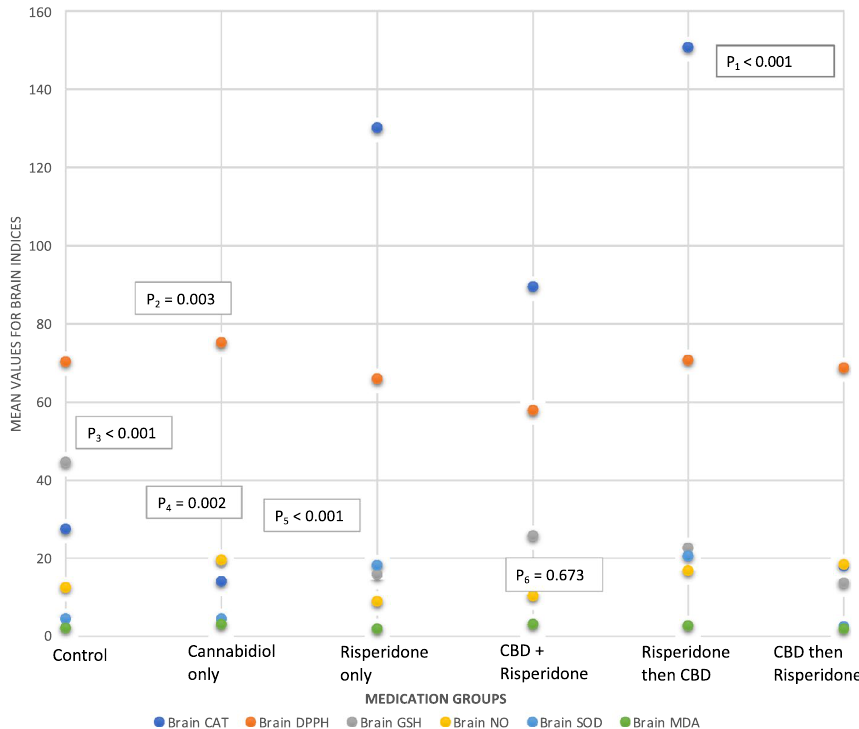
Figure 4. Inter-group comparison of assay of antioxidant indices assay after the last dose of medications. There were intergroup differences in the Brain’s GSH, SOD, CAT, SOD and DPPH results, but there were no intergroup differences in the brain’s MDA. Group 1: Control Group; Group 2: Cannabidiol only; Group 3: Risperidone only; Group 4: Cannabidiol + Risperidone; Group 5: Risperidone then Cannabidiol; Group 6: Cannabidiol then Risperidone. P 1 = P-value for brain CAT differences between groups; P 2 = P-value for brain DPPH differences between groups; P 3 = P-value for brain GSH differences between groups; P 4 = P-value for brain NO differences between groups; P 5 = P-value for brain SOD differences between groups; P 6 = P-value for brain MDA differences between